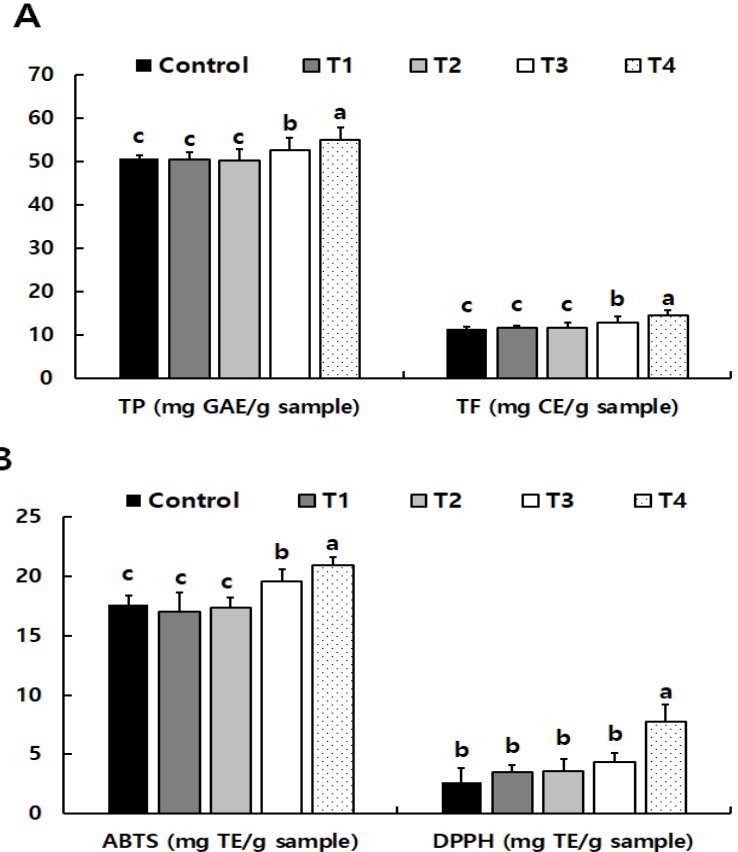
Figure 4. ( A ) Total phenolic and flavonoid contents, and ( B ) ABTS and DPPH radical scavenging activity of purple wheat sprouts, were affected by the duration (T1–T4) of low-temperature treatment (<4 ◦ C). TP, total phenolic content; GAE, gallic acid equivalent; TF, total flavonoid content; CE, catechin equivalent; TE, Trolox equivalent. According to ANOVA, different letters indicate significant differences between groups ( p < 0.05; ANOVA, followed by Duncan’s multiple range test).